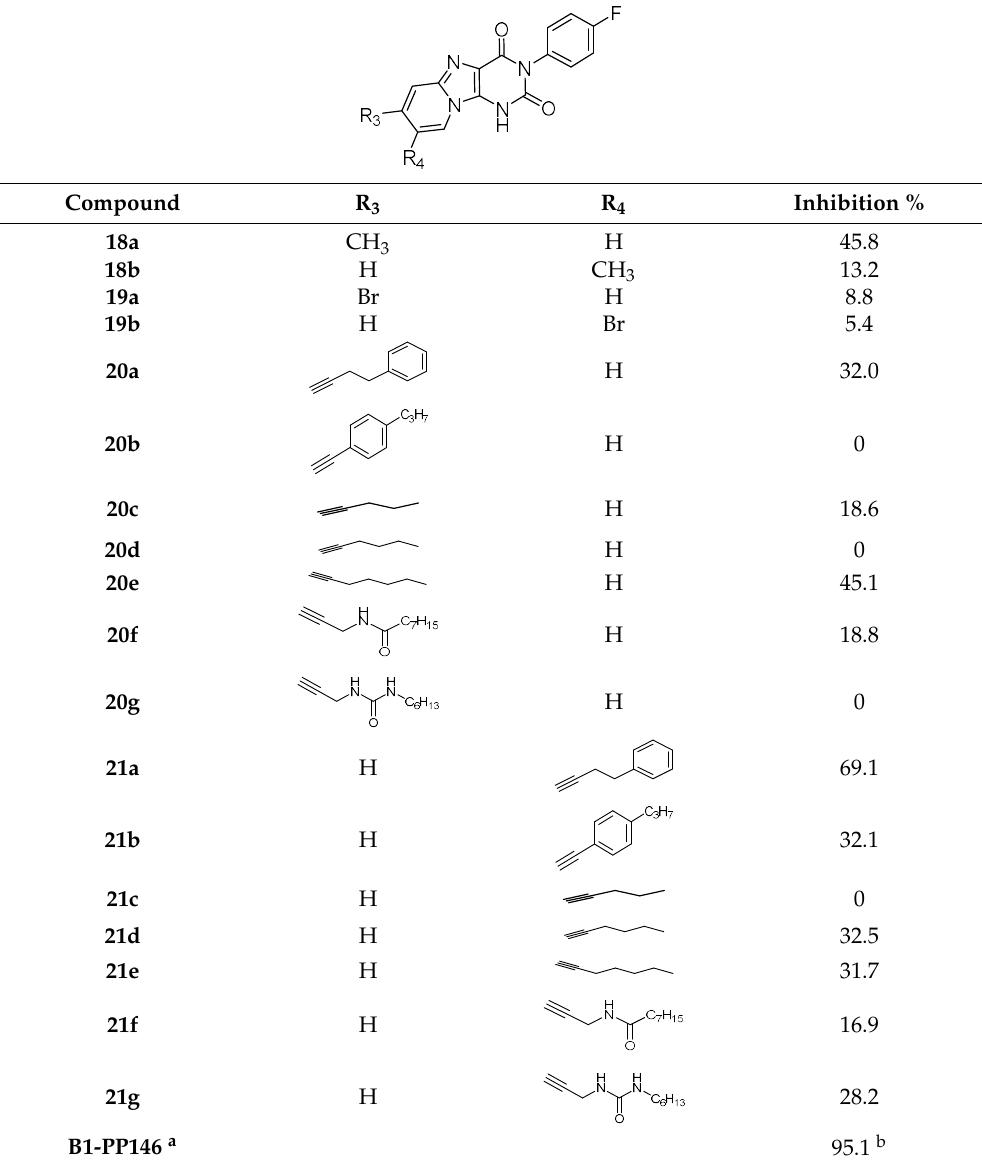
Table 5. SAR of the C 7 and C 8 moiety by Sonogashira cross-coupling and Mtb ThyX inhibition at 200 µM by the NADPH oxidase assay.